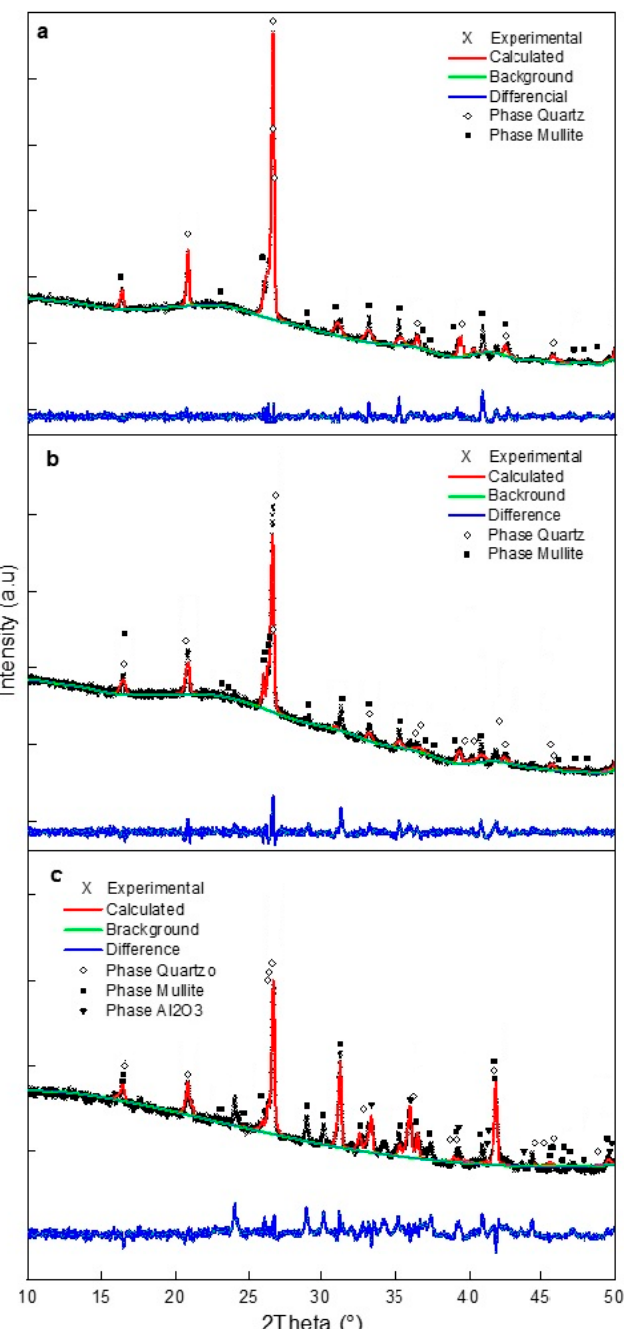
Figure 6. X-ray di ff raction patterns of ( a ) Mixture 1, ( b ) Mixture 2, and ( c ) Mixture 3 with corresponding Figure 6. X-ray diffraction patterns of ( a ) Mixture 1, ( b ) Mixture 2, and ( c ) Mixture 3 with Rietveld corresponding Rietveld refinement.